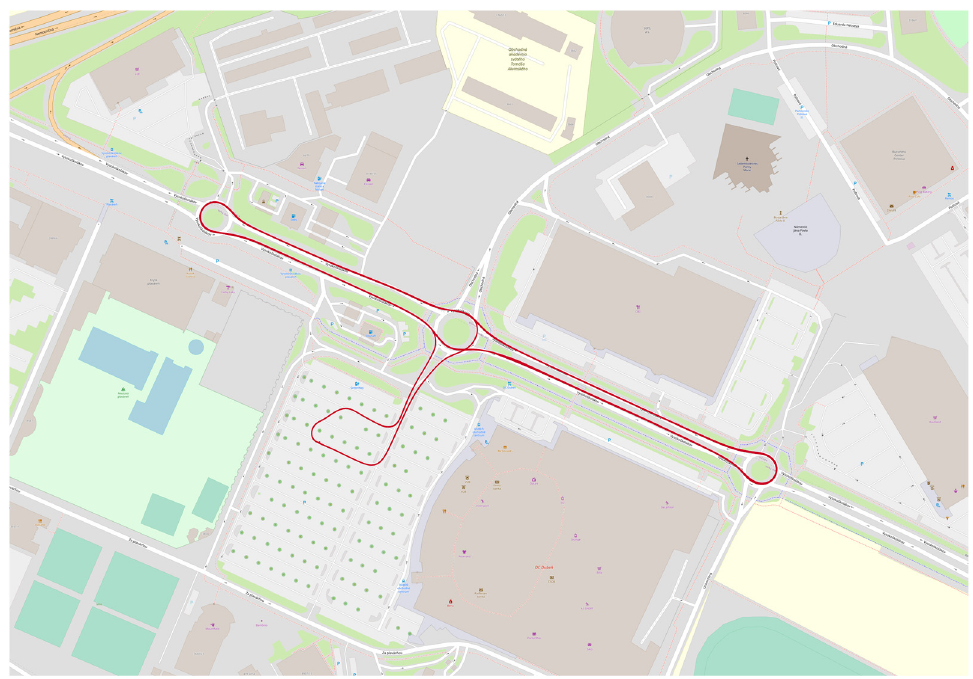
Figure 8. Test route TR2 in city of Žilina on street of Vysokoškolákov on OSM map layer with 4 passes of three roundabouts.